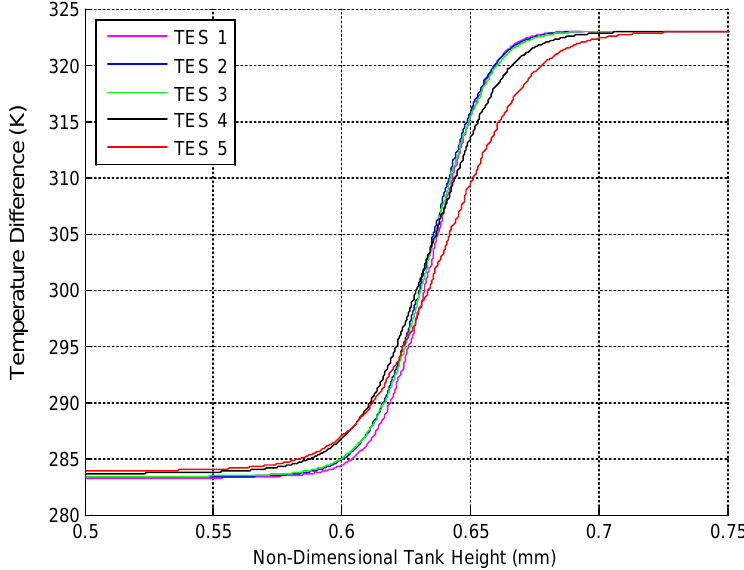
Figure 7. Temperature profile and thermocline in different tank designs (water velocity of 1.5 cm/s, tans water temperature 50 °C, inlet water temperature 6 °C).